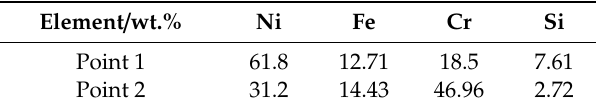
Figure 8. EDS point analysis of the as-sprayed coating ( a ) and the annealed one ( b ) at 990 °C for 20 min. Table 4. EDS point analysis of the as-sprayed coating.